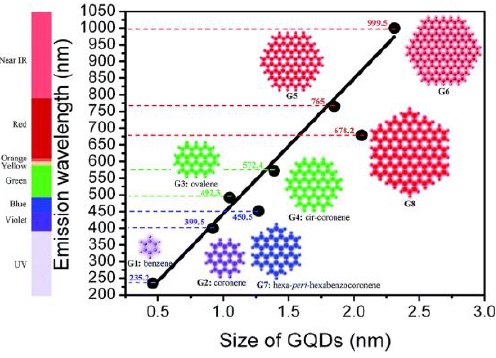
Figure 5. Estimated variation of the emission wavelength with the size for GDs. Reproduced with permission of [54].